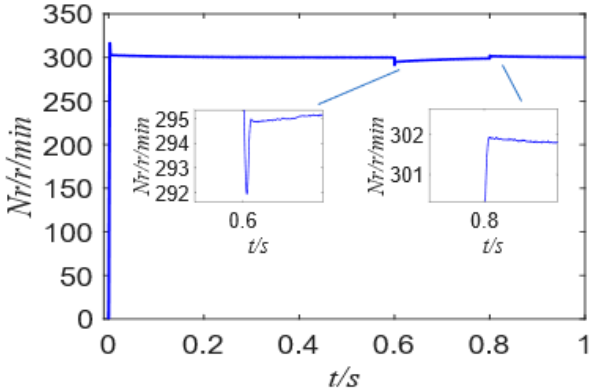
Figure 9. Rotation speed of FCS-MPCC.